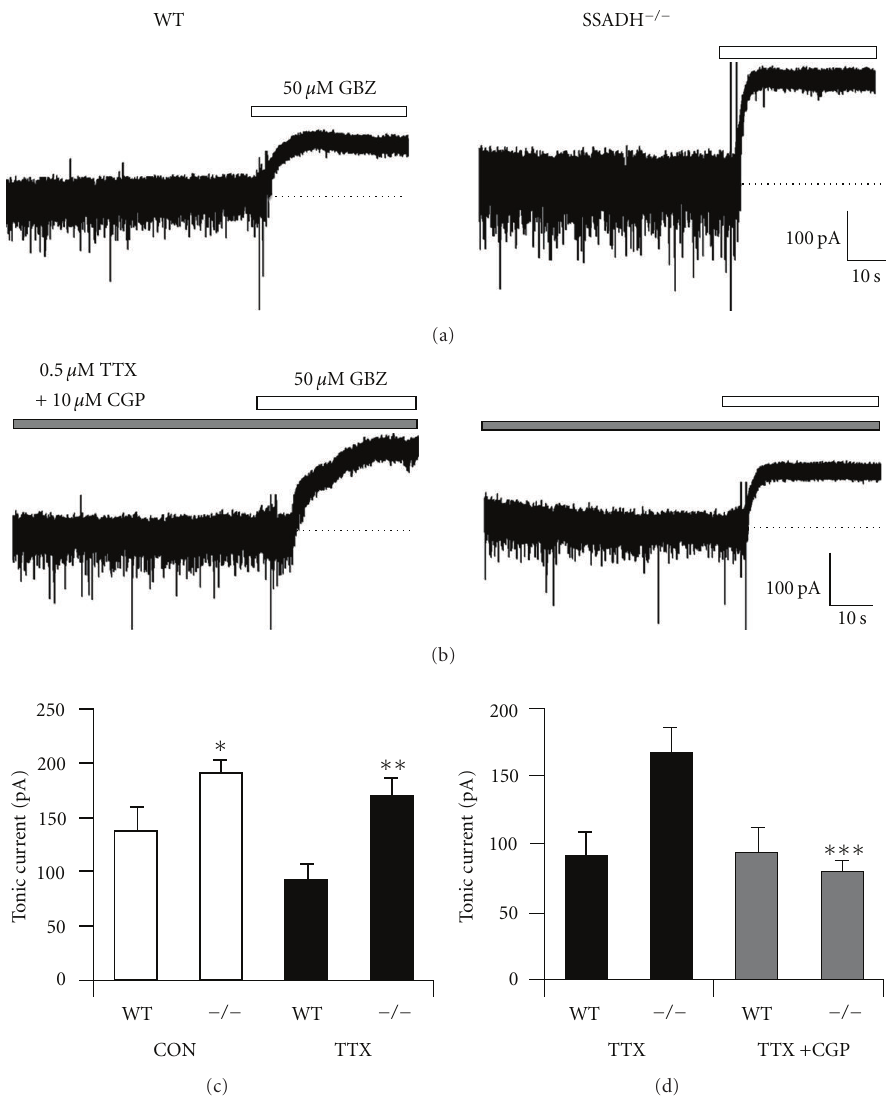
Figure 3: SSADH-deficient mice have enhanced tonic GABA A currents in VB TC neurons. (a) and (c) VB TC neurons from SSADH − / − mice display enhanced tonic GABA A currents compared with their WT control littermates. (b) and (d) In TTX, tonic current amplitudes in both SSADH − / − and WT mice are reduced compared to control conditions. CGP55845 reduces the amplitude of the tonic GABA A current observed in SSADH − / − to a similar level found in WT mice. (a–d) reproduced from reference [58].